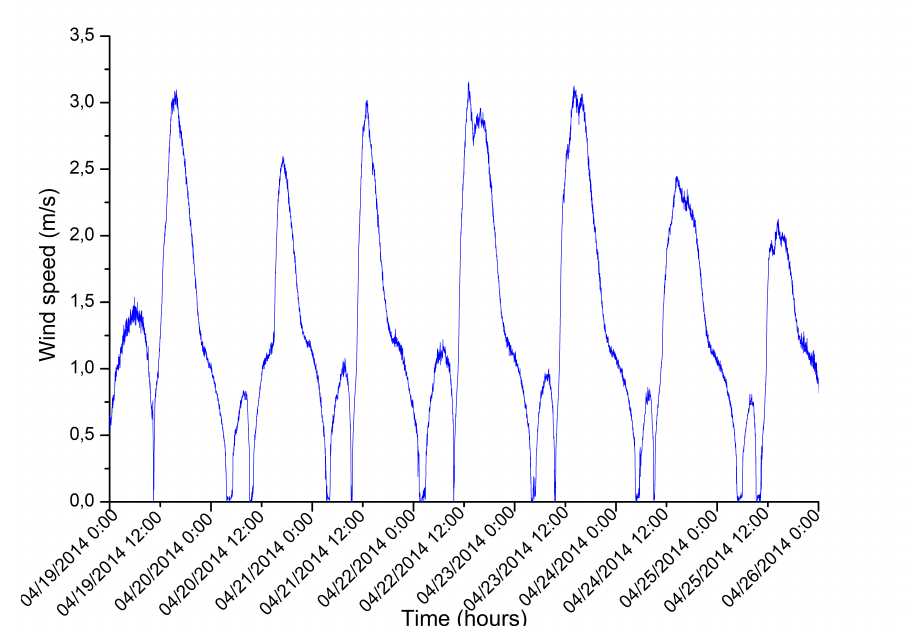
Figure 6. Wind speed measured by the anemometer/wind